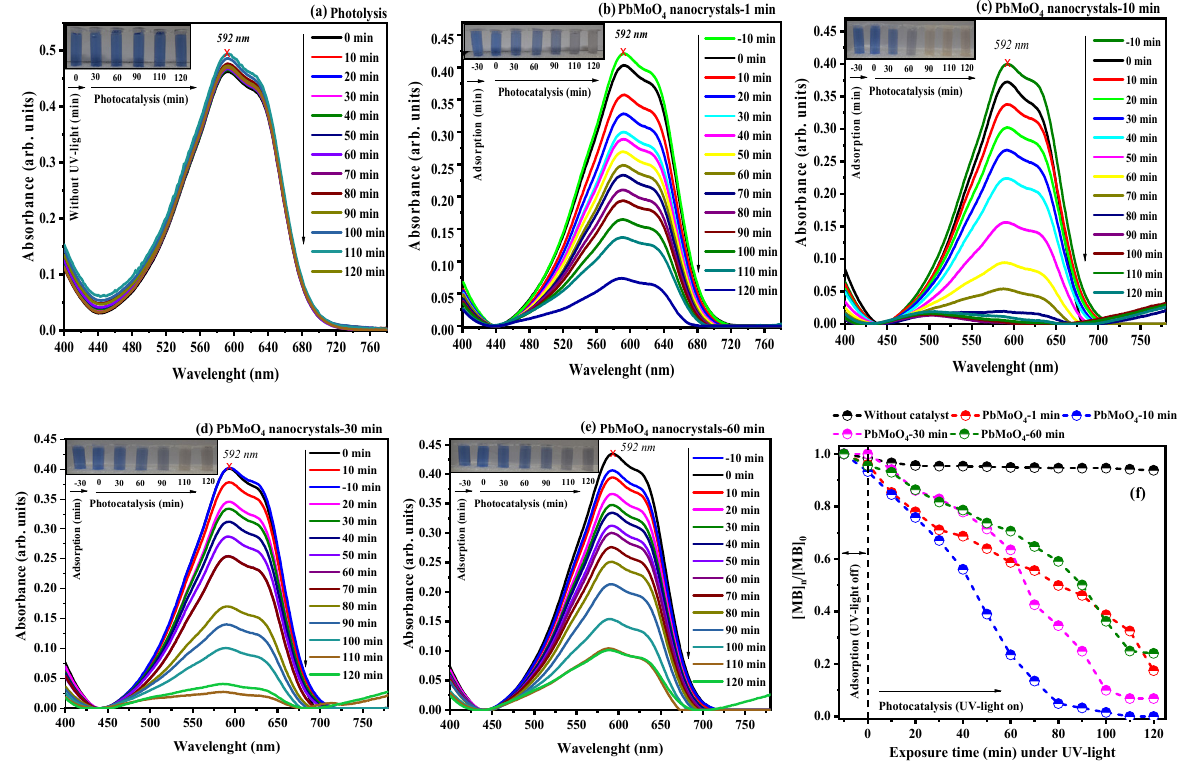
Figure 8. The evolution of photocatalytic degradation of RBBR dye (anionic) under ( a ) UV light and ( b – e ) using the PbMoO 4 nanoparticles. Figure ( f ) represents all experiments’ concentration vs. exposure time under UV light.